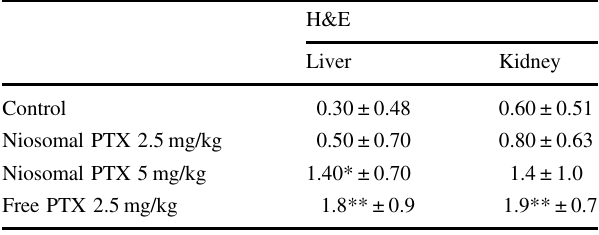
Table 4 The hepatic damage score (HDS) in hematoxylin eosin- stained sections of different groups